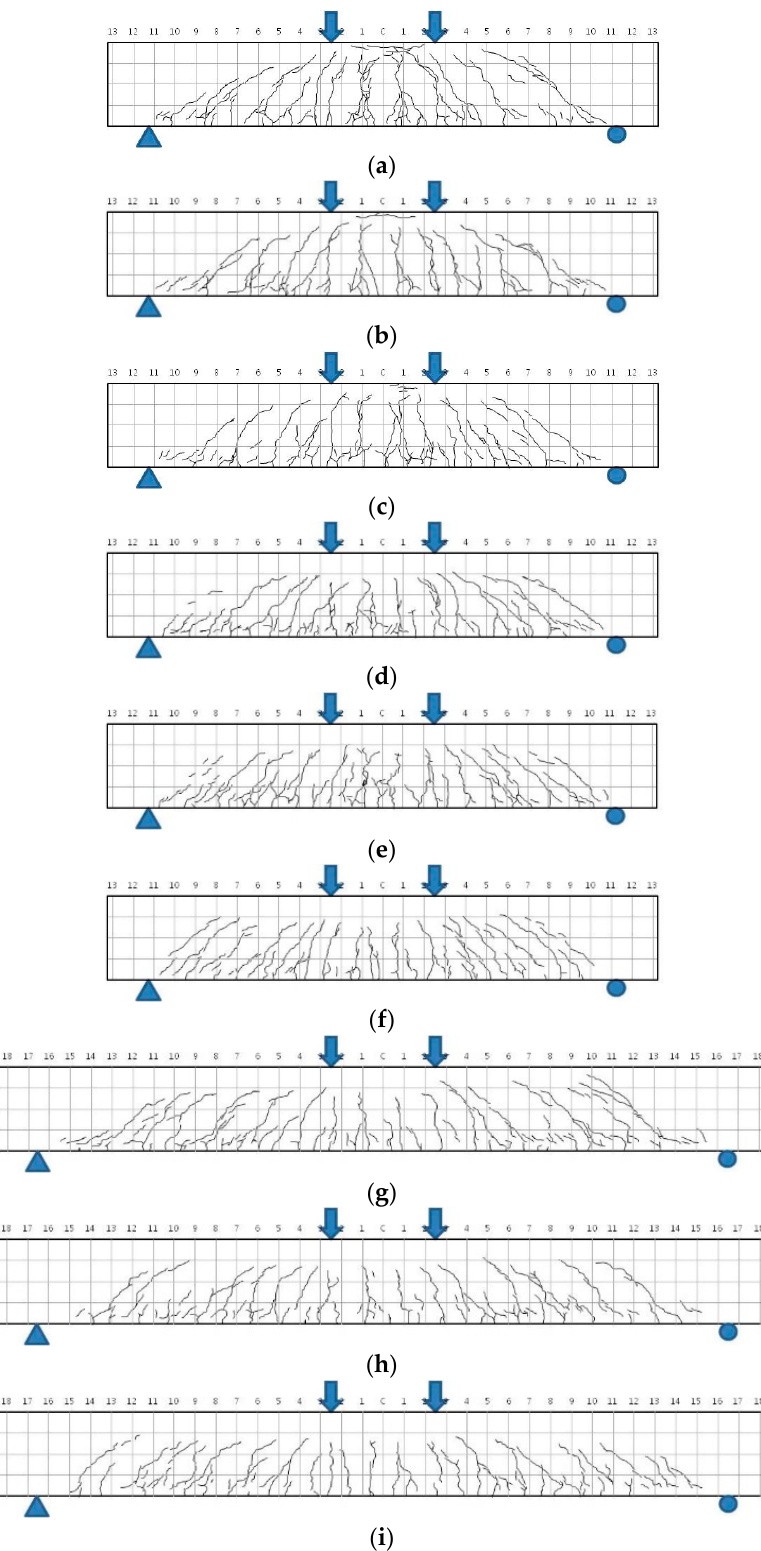
Figure 5. Crack patterns of specimens at peak load: ( a ) B3-2.5a; ( b ) B3-2.5b; ( c ) B3-2.5c; ( d ) B6-2.5a; ( e ) B6-2.5b; ( f ) B6-2.5c; ( g ) B6-4.0a; ( h ) B6-4.0b; ( i ) B6-4.0c. ( e ) B6-2.5b; ( f ) B6-2.5c; ( g ) B6-4.0a; ( h ) B6-4.0b; ( i )